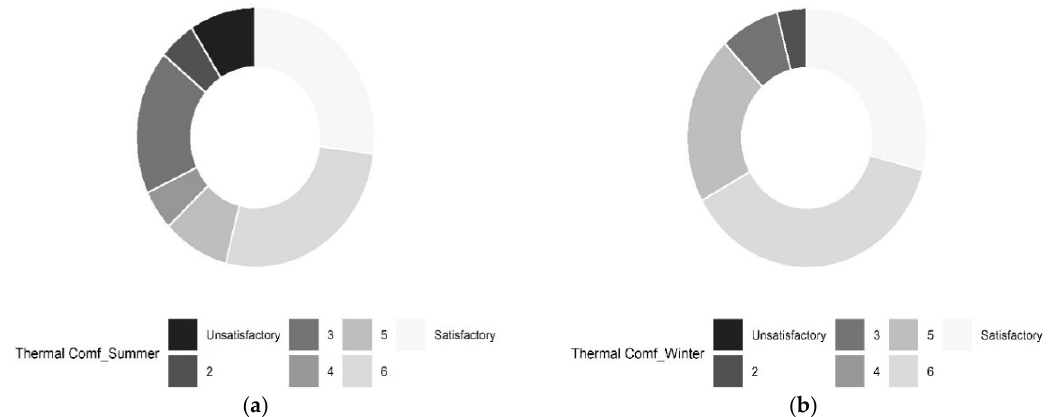
Figure 3. Satisfaction vote for the thermal conditions in the office: ( a ) in summer; ( b ) in winter.